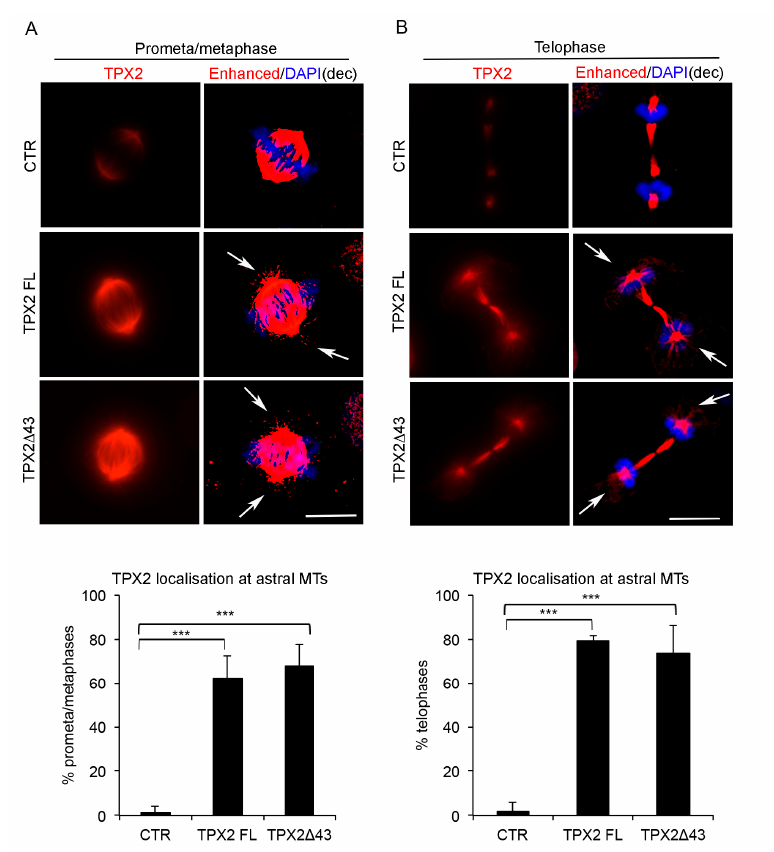
Figure 2. Mitotic localisation of TPX2 in overexpressing cell lines. Localisation of TPX2 at spindle microtubules (MTs) in VENUS (control—CTR) and TPX2-overexpressing cell lines in late prometa/metaphase (IF panels in ( A )) or telophase (IF panels in ( B )) cells (12 h induction, formaldehyde-fixed). Enhanced deconvolved panels are shown on the right column of each panel, to depict TPX2-positive astral MTs (white arrows) that are not present in the control cell line. Scale bars: 10 μ m. Histograms below show the percentage of late prometa/metaphases ( A ) or telophases ( B ) displaying TPX2 staining at astral MTs. At least 50 cells per condition were counted, from three independent experiments. Bars indicate standard deviations. *** p < 0.0001, chi-square (and Fisher’s exact)